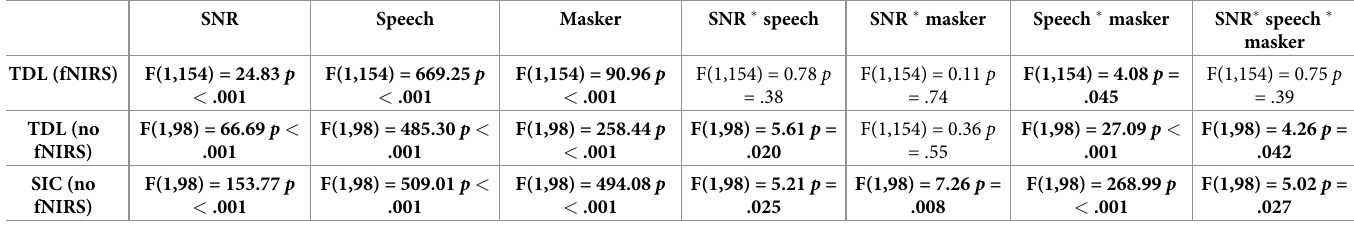
Table 1. Summary of results from ART tests for behavioral measures. The behavioral measures are task difficulty level (TDL) recorded during fNIRS session and in the behavioral session with no fNIRS, and speech intelligibility scores (SIC) recorded in the behavioral session. SNR